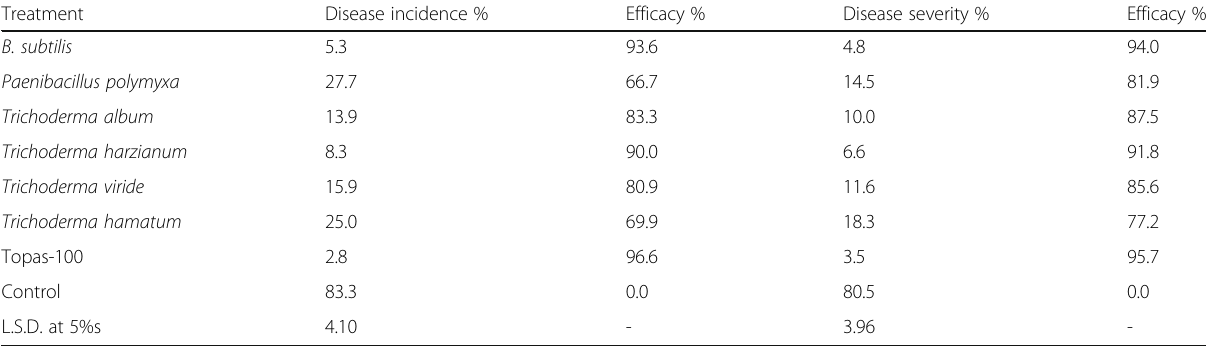
Table 2 Effect of spraying bio-agent to control powdery mildew disease on squash plants under greenhouse conditions Treatment